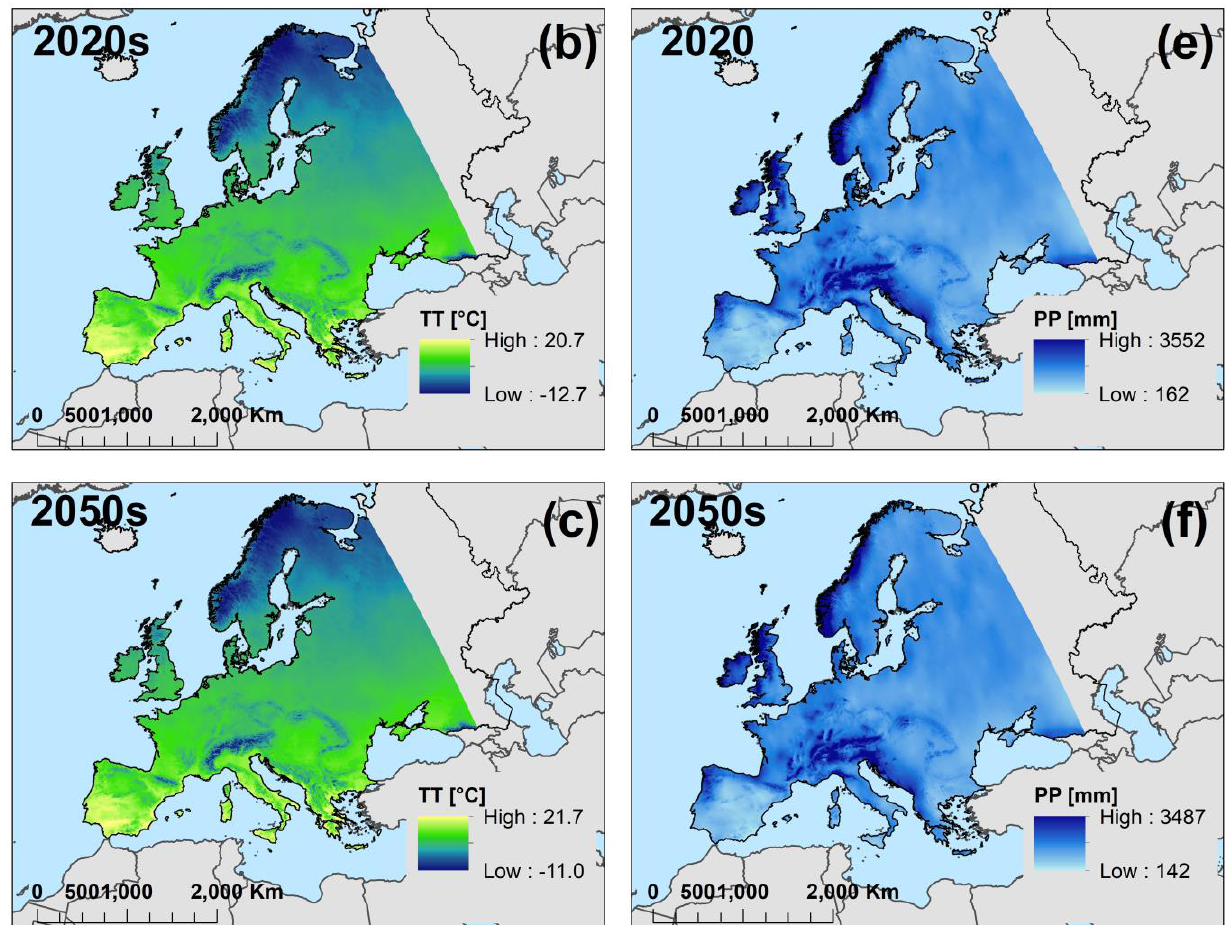
Figure 1. Climate variables as input data in Europe and output results list. ( a ) Mean annual air temperature (TT) in 1990s. ( b ) Mean annual air temperature (TT) in 2020s. ( c ) Mean annual air temperature (TT) in 2050s. ( d ) Mean annual precipitation (PP) in 1990s. ( e ) Mean annual precipitation (PP) in 2020s. ( f ) Mean annual precipitation (PP) in 2050s.